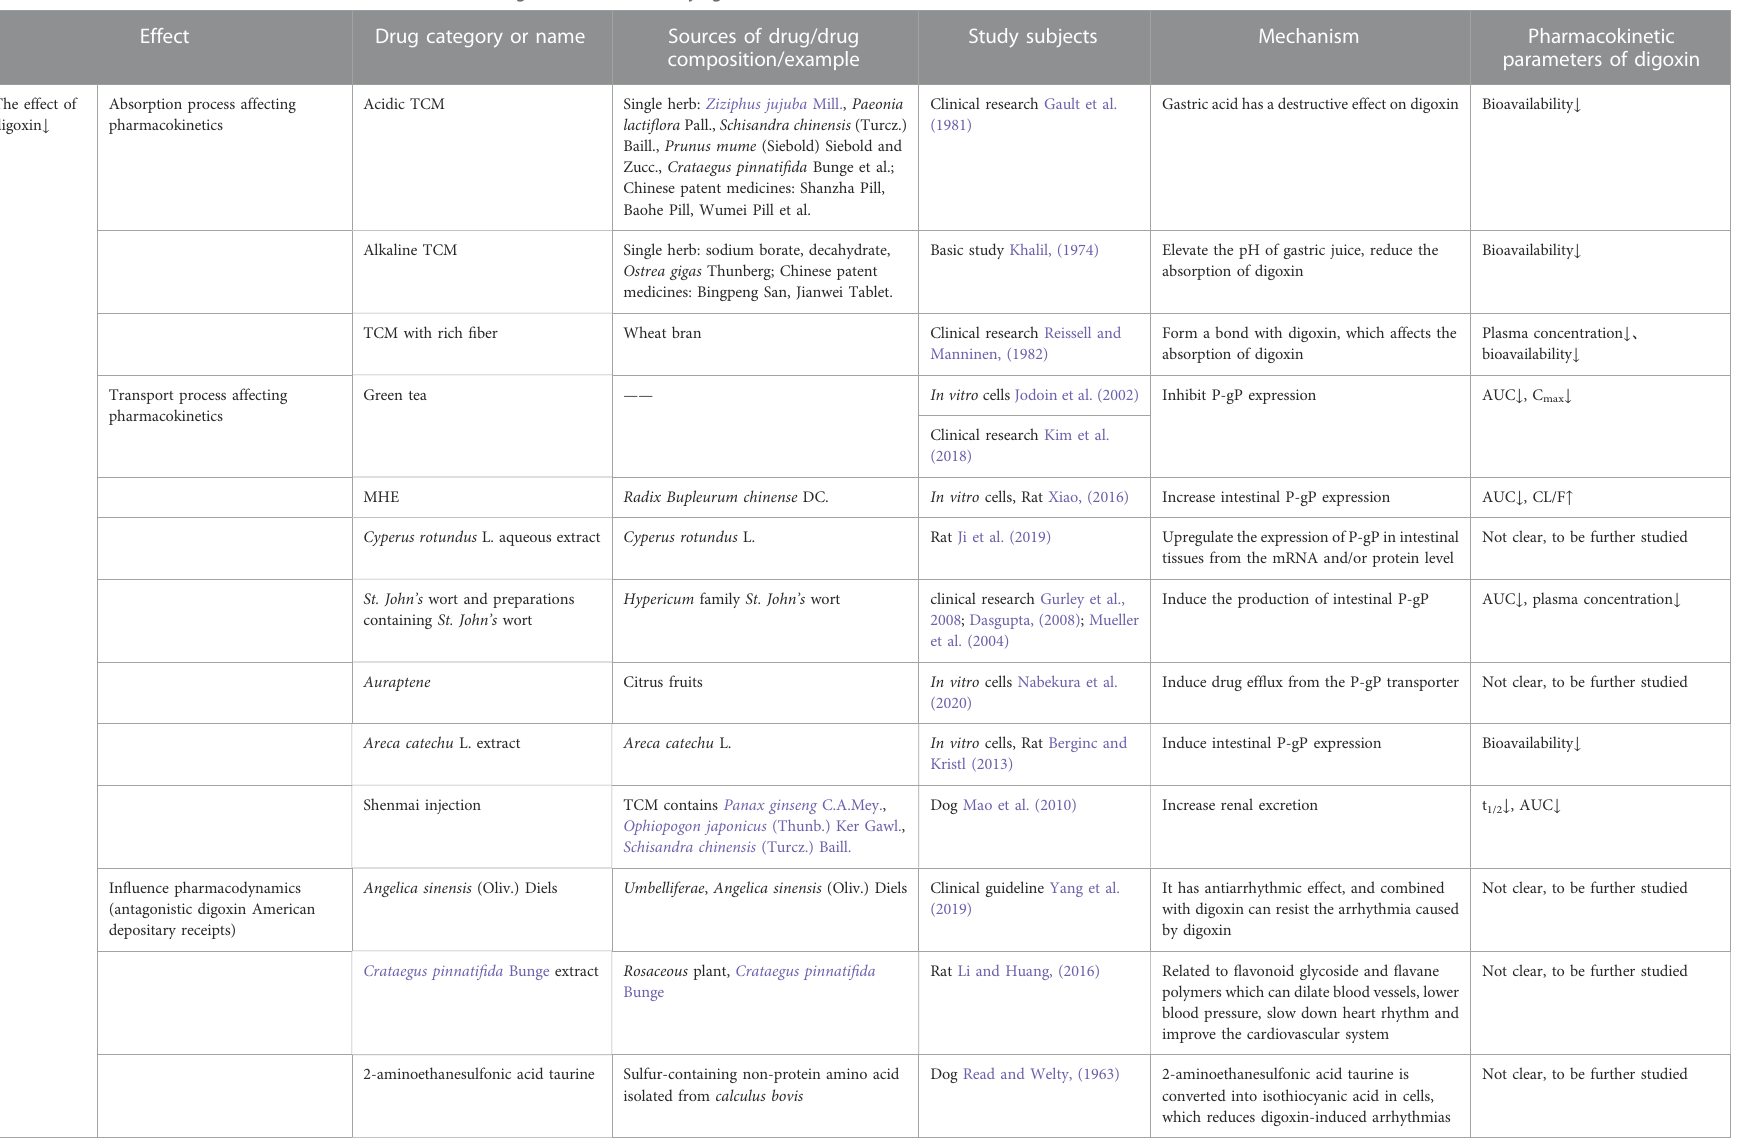
TABLE 1 ( Continued ) Interactions between TCM formulations and digoxin, and the underlying